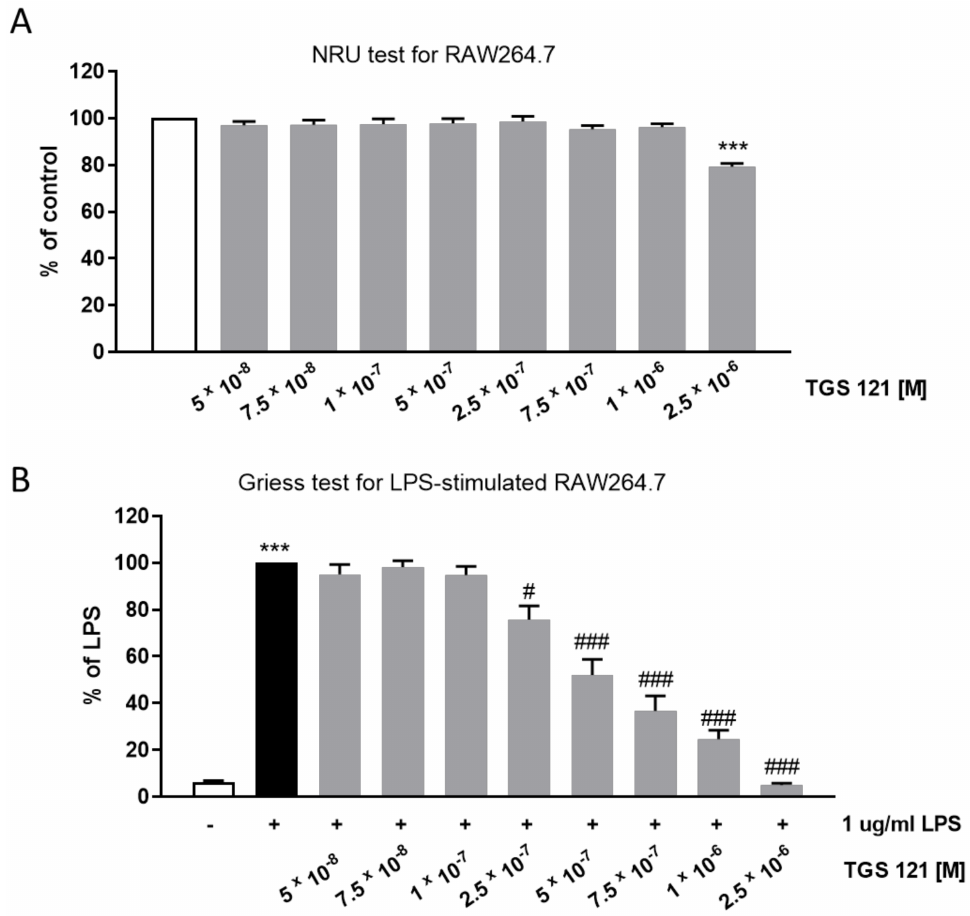
Figure 1. Neutral red uptake test ( A ) and Griess test ( B ) for RAW264.7 macrophages treated with TGS 121. *** p < 0.001 vs. control; # p < 0.05, ### p < 0.001 vs. 1 ug/mL lipopolysaccharide